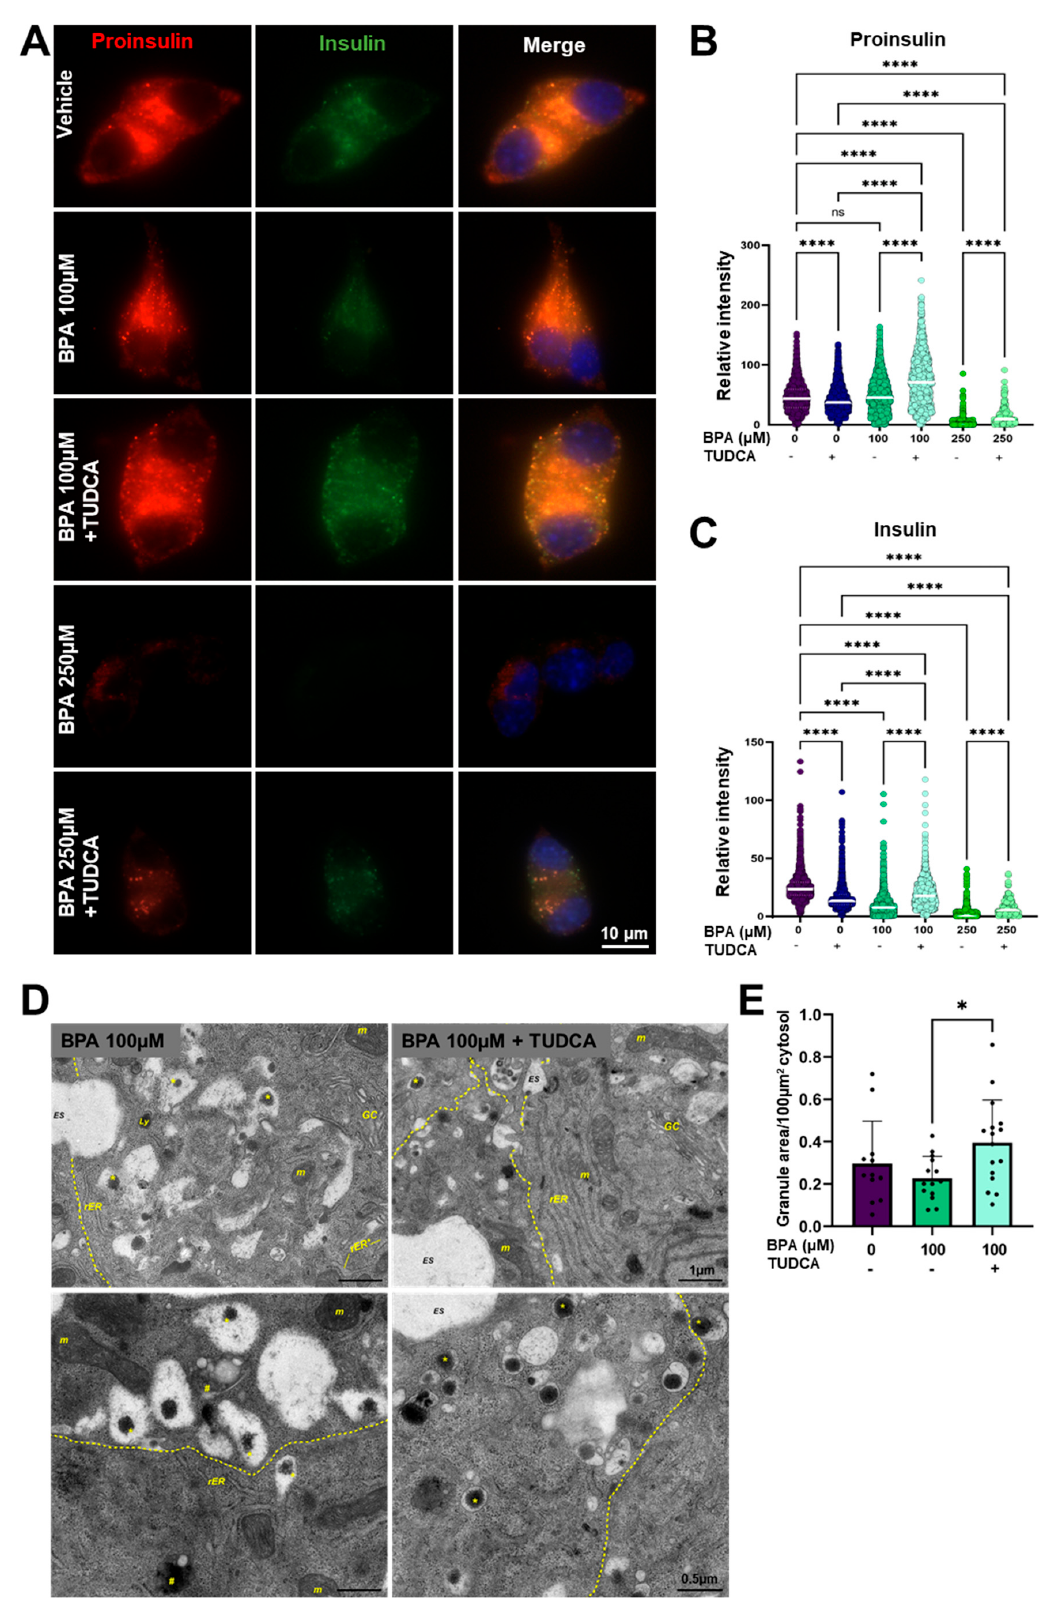
Figure 7. TUDCA improves insulin synthesis and processing in MIN6 cells treated with BPA. ( A ) Representative fluorescence microscopy images with MIN6 cells after 24 h of treatment with 100